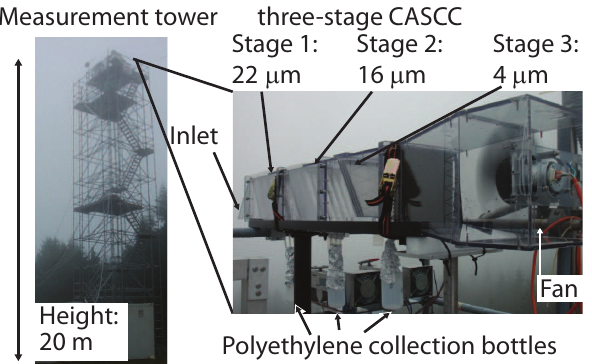
Fig. 1. Pictures of the measurement tower at Schm¨ucke (50 ◦ 39 ′ N, 10 ◦ 46 ′ E, 937 m a.s.l, Germany) and of the three-stage Caltech Active Strand Cloudwater Collector (CASCC, as described in Sect. 2.2) mounted on its top.